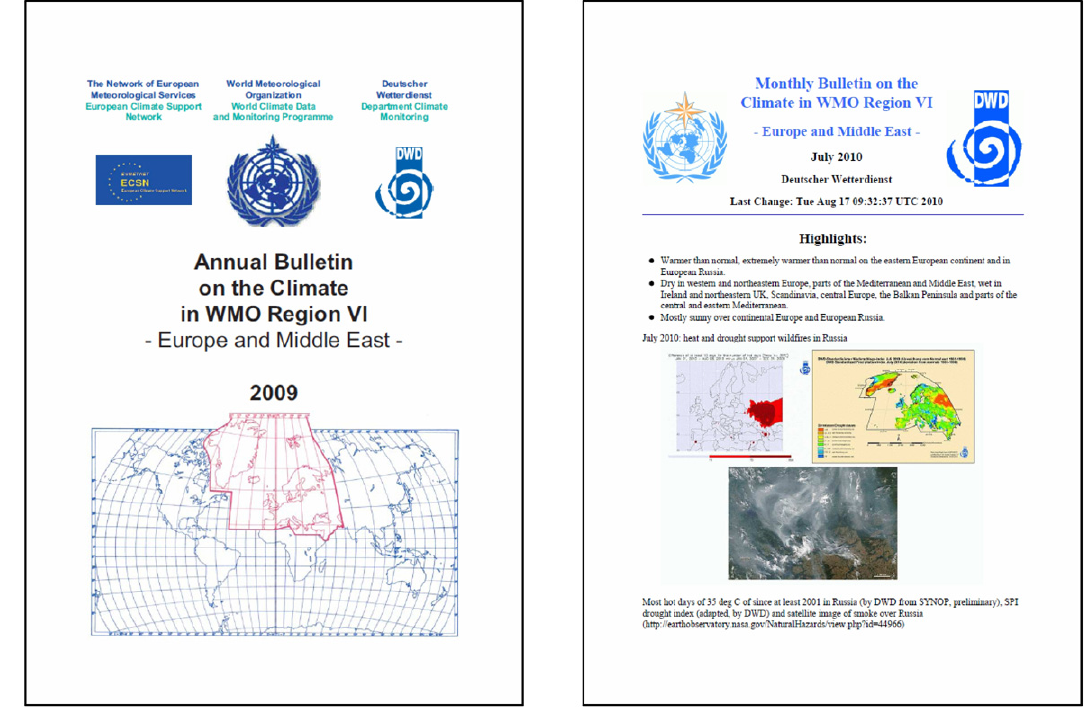
Figure 2. Annual and Monthly Bulletin on the Climate in WMO Region VI.